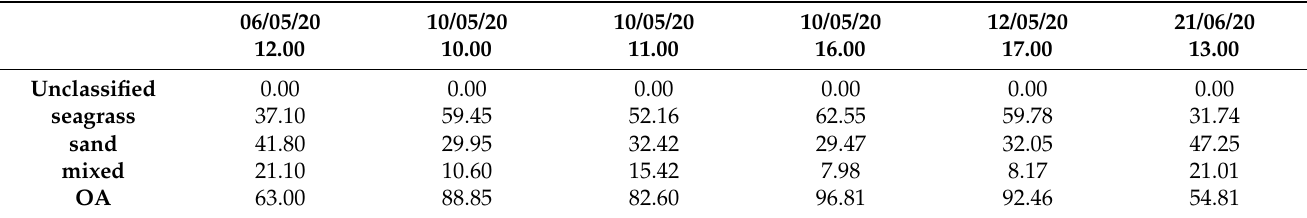
Table A2. Support vector machines (SVM) classification statistics of the coverage percentages. On 06/05/20, parts of seagrass have been classified as sand and mixed substrate, increasing the coverage percentages of these classes. On 12/05/20, the coverage percentages are closer to the reference percentages (10/05/20, at 16.00). On 21/06/20, almost 30% of seagrass has been misclassified as sand and mixed substrate. The overall accuracies vary from 54.81 to 96.81%.